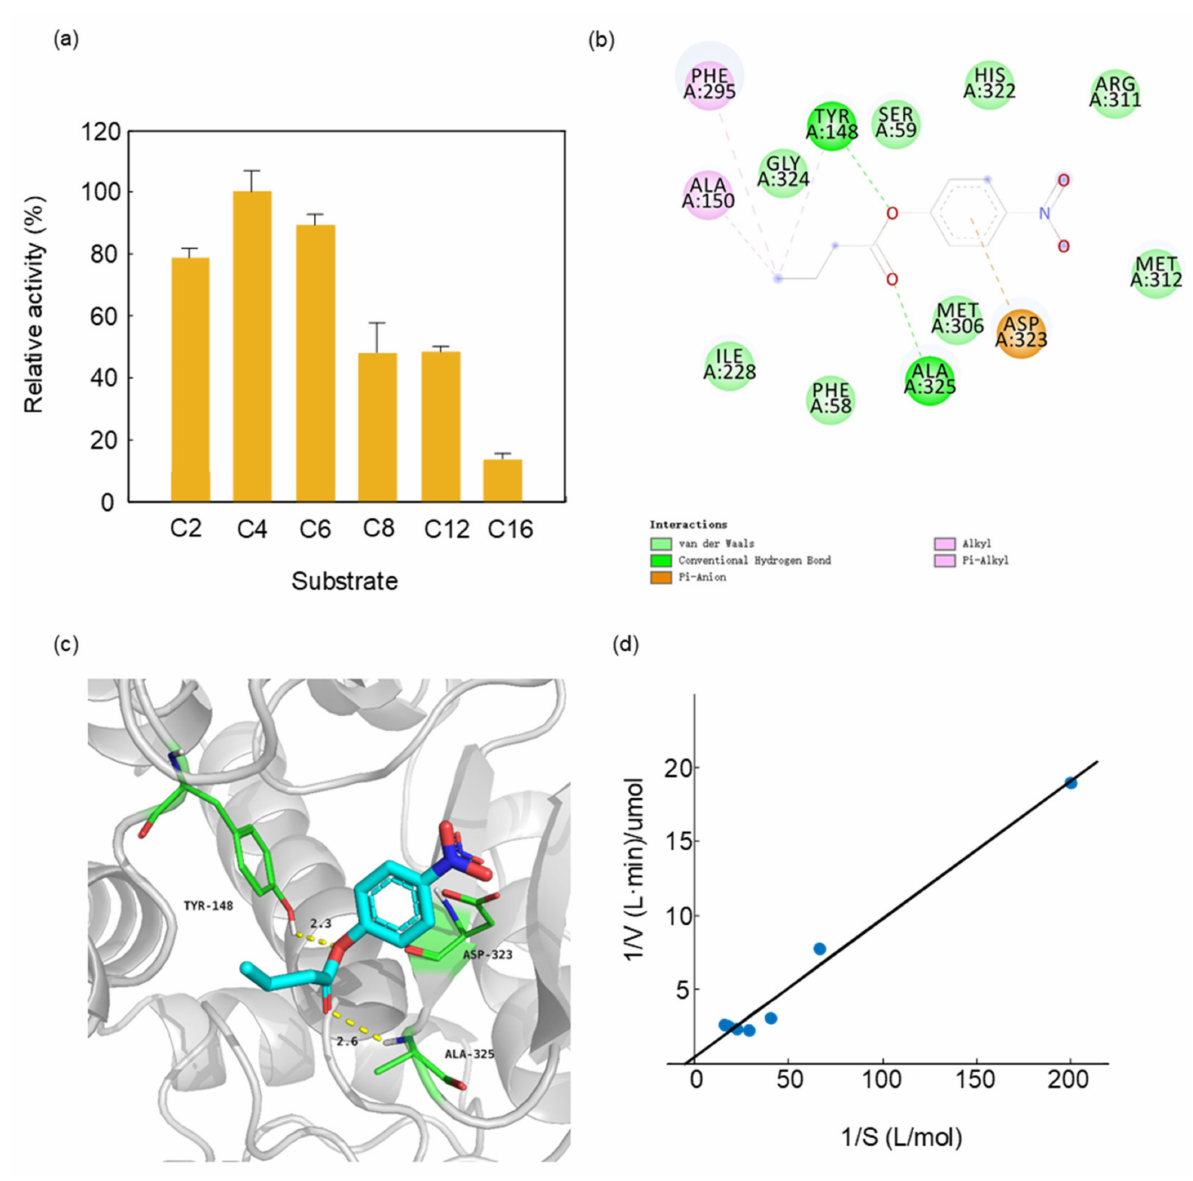
Figure 3. ( a ) Substrate specificity of PTCL1-EstA; ( b ) 2D ligand interaction diagram of PTCL1-EstA with a docked p-nitrophenyl butyrate (C4); ( c ) active site of PTCL1-EstA with a docked p-nitrophenyl butyrate (C4); ( d ) K m / V max values of